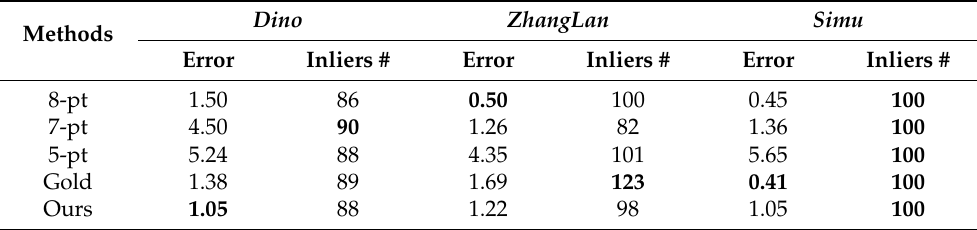
Ours Table 2 is the average re-projection error from feature pixels u , u (cid:48) to P E X , P (cid:48)